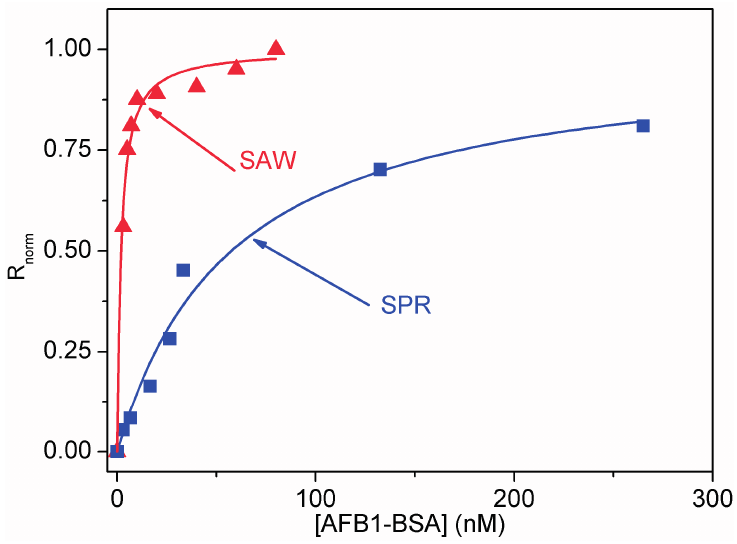
Figure 7. Langmuir-like binding curves obtained with the SPR and LW-SAW sensors pH = 7.5 and T = 25